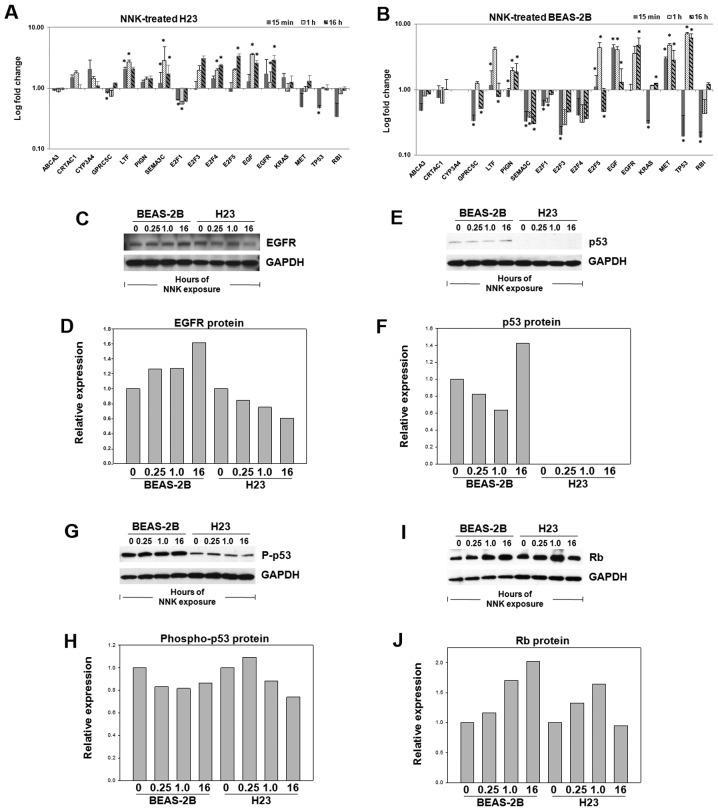
NNK-induced gene and protein expression in H23 and BEAS-2B. Gene expression fold change in cell lines treated with NNK (100 nM) vs. control in (A) human lung adenocarcinoma cells H23 and (B) normal lung epithelial cells BEAS-2B. The gene expression was normalized with endogenous control gene UBC. An asterisk above a bar indicates significant (P<0.05) differential expression in repeated ANOVA tests of five biological samples and three technical repeats in qRTPCR assays. Protein expression measured by western blots in NNK treated cell lines (C and D) BEAS-2B and H23 for EGFR, (E and F) p53, (G and H) phospho-p53 and (I and J) Rb. The protein expression was quantified with densitometry and normalized with endogenous control protein GAPDH in three biological repeats.